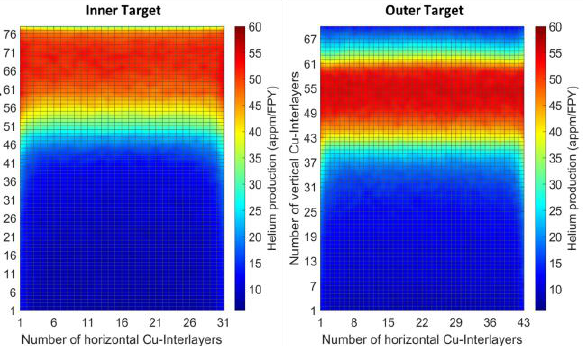
Figure 26. He-production (appm/FPY) distribution on Cu/CuCrZr components of the inner ( left ) and outer ( right ) target, with HCPB blanket.